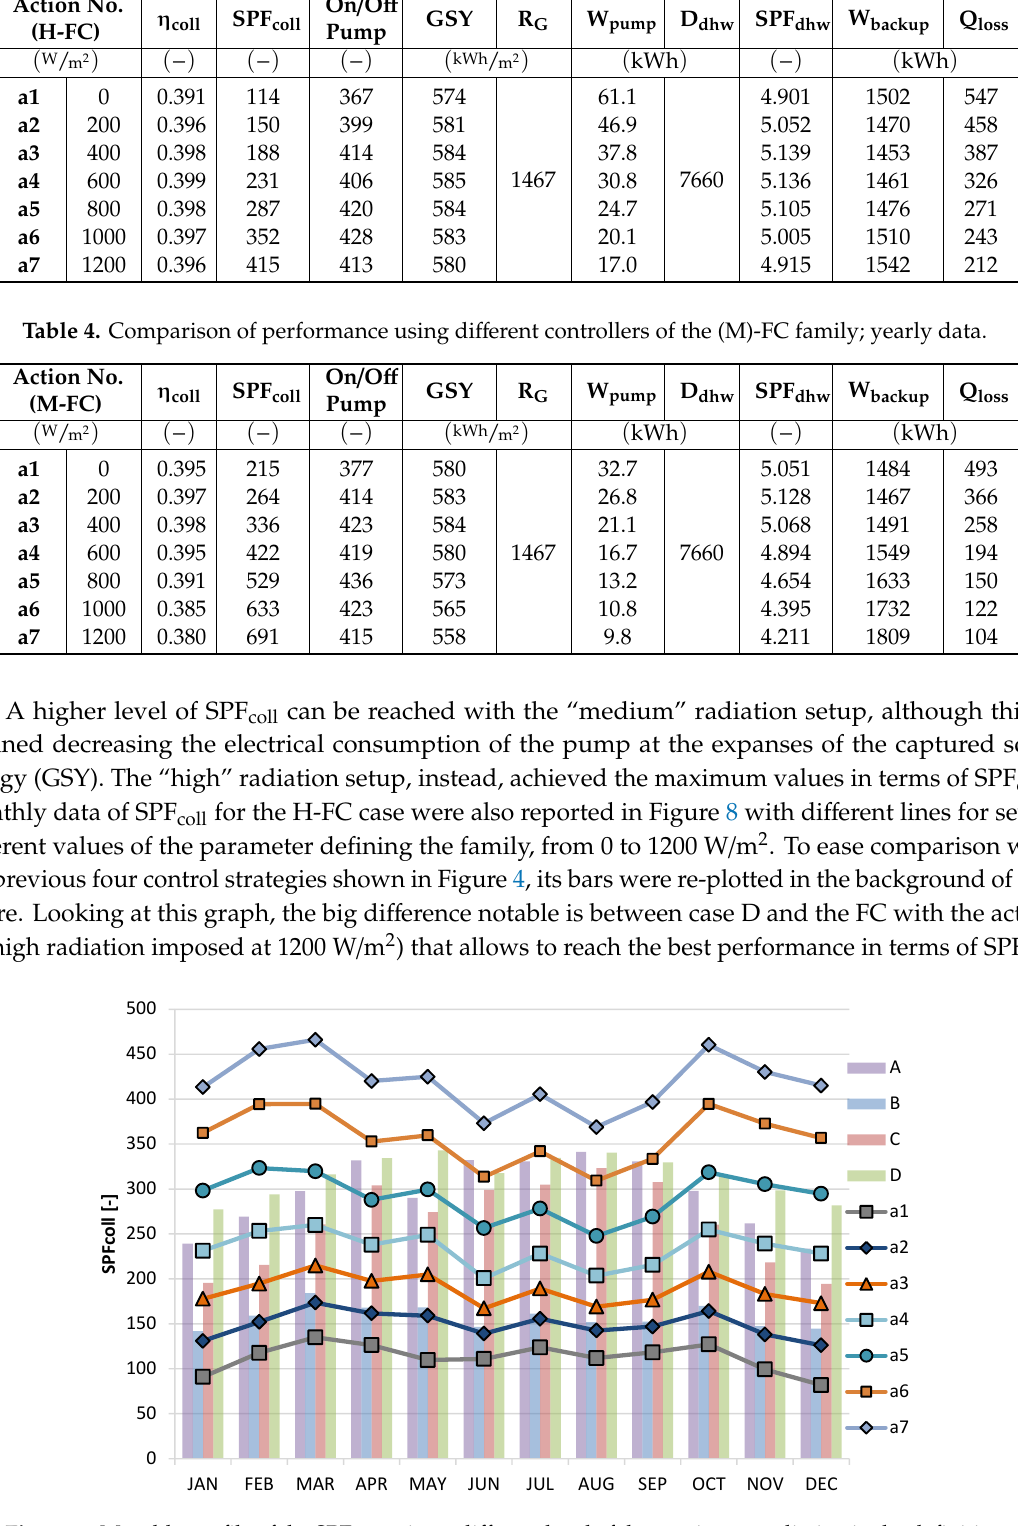
Figure 8. Monthly profile of the SPF coll using a different level of the maximum radiation in the definition of the input membership function compared with the four basic control strategies.